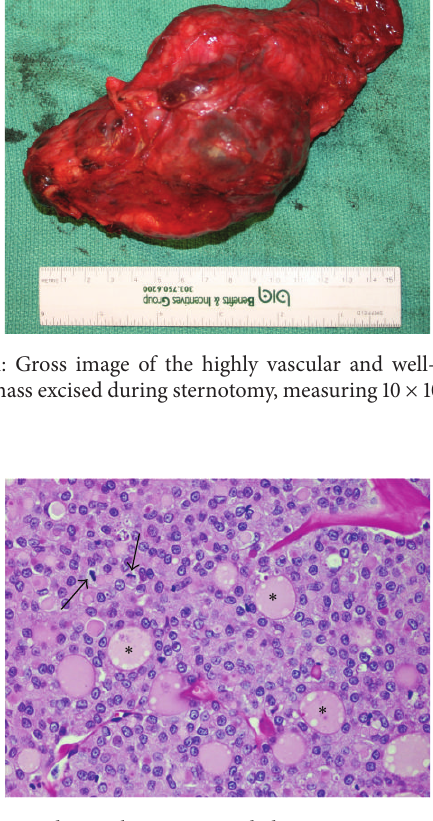
Figure 2: Mediastinal mass excised during sternotomy. Ectopic thyroid carcinoma characterized by neoplastic polygonal cells sup- ported by a fine fibrovascular stroma and frequently arranged in follicular structures filled with colloid (asterisk). Numerous mitotic figures (arrows) are present throughout this neoplastic cell popula- tion. H&E stain